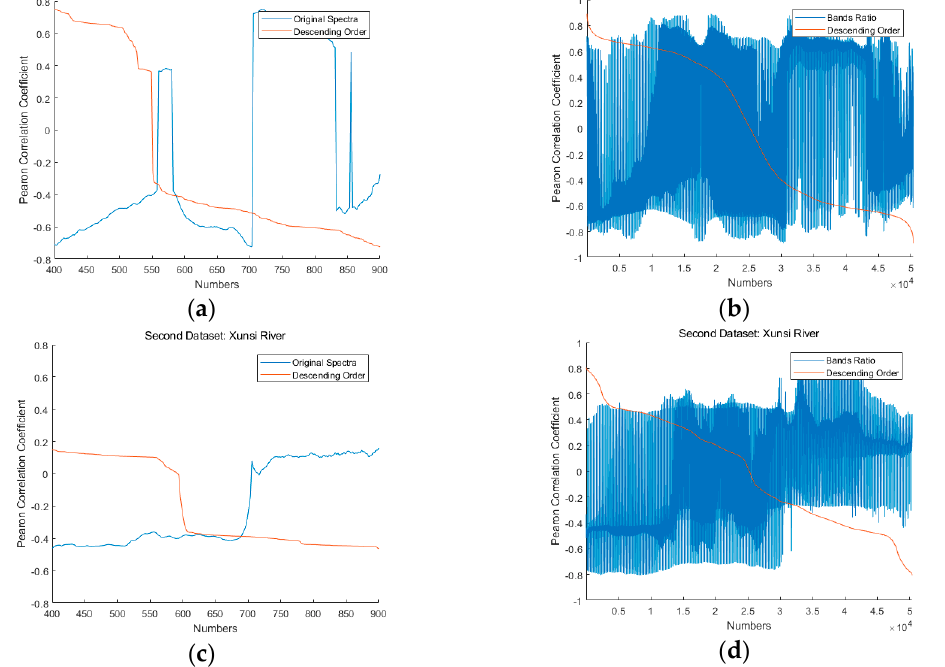
Figure 5. Pearson correlation coefficients with the Nemerow index. ( a ) Original spectra for Shahu Port. ( b ) Band ratio for Shahu Port. ( c ) Original spectra for Xunsi River. ( d ) Band ratio for Xunsi River.